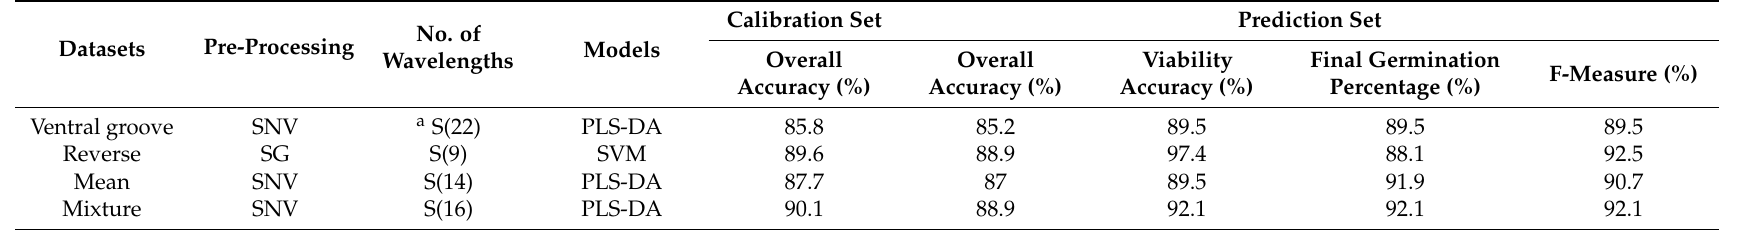
Table 3. The best results of models based on each spectral